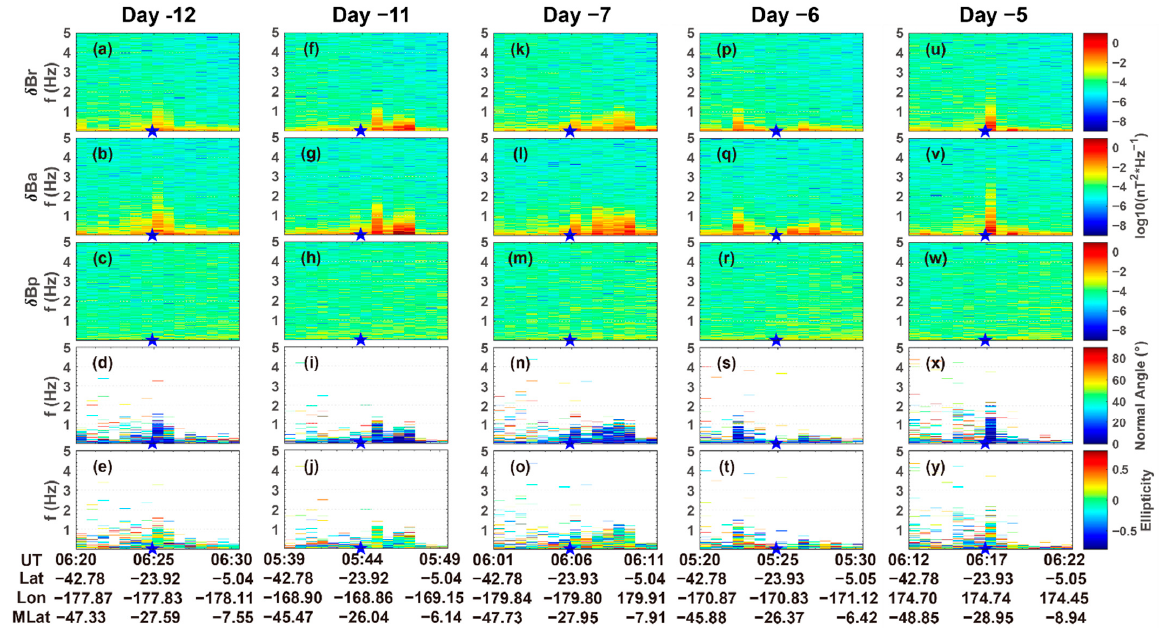
Figure 7. Power spectral density and polarization parameters corresponding to Swarm A orbits